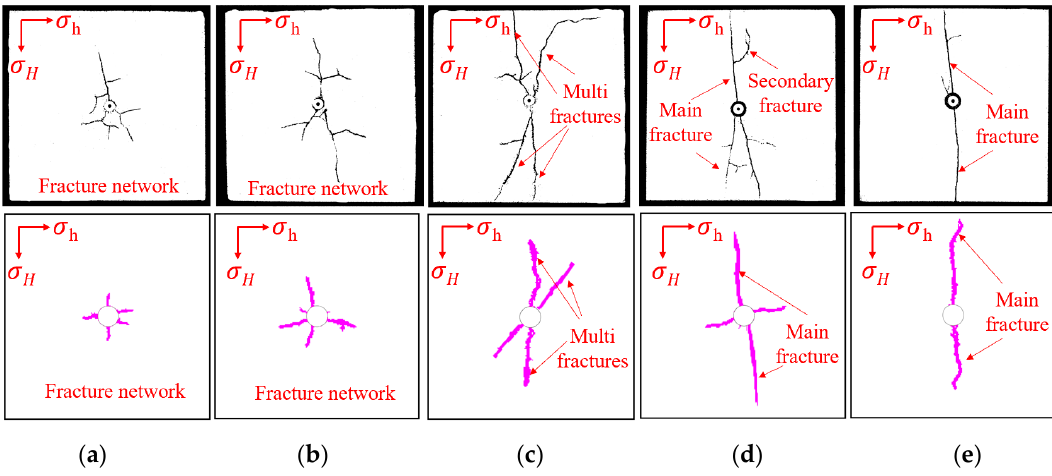
Figure 11. The comparison between experimental observations and numerical simulation results when injecting supercritical carbon dioxide under various stress states. ( a ) σ H - σ h = 0; ( b ) σ H - σ h = 1 MPa; ( c ) σ H - σ h = 2 MPa; ( d ) σ H - σ h = 3 MPa; ( e ) σ H - σ h = 4 MPa.